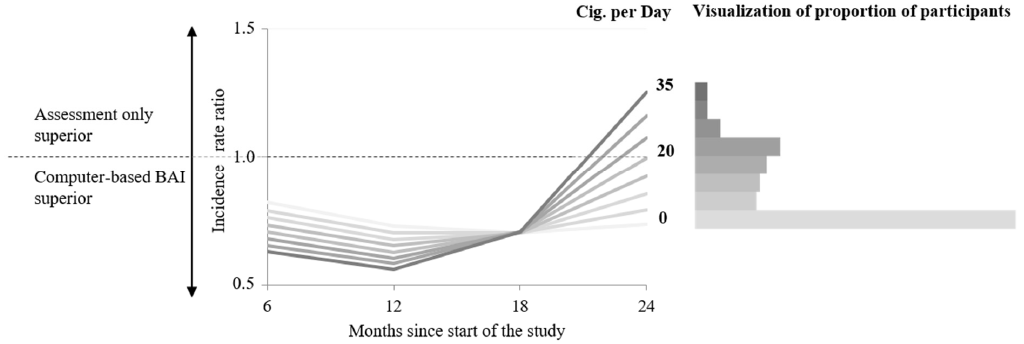
Figure 2. Effect of the computer-based BAI compared to assessment only.